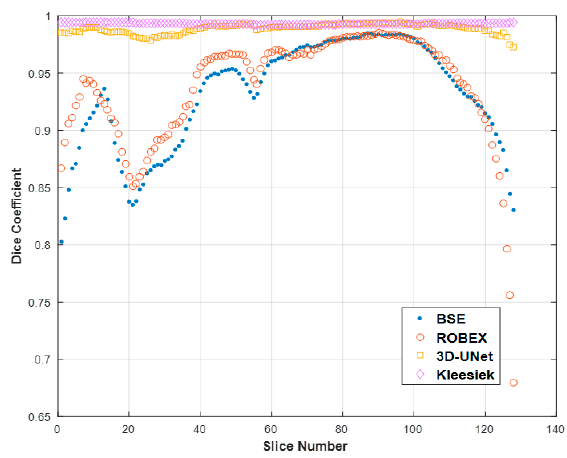
Figure 3. Dice comparison of 3D-UNet with BSE, ROBEX and Kleesiek’s method on a single test brain MRI scan slice-by-slice. BSE and ROBEX failed to correctly segment the brain in the initial slices of the brain MRI volume. The Dice score in the slices (from 80–140 slices) for both the competitor algorithms is less than 0.90 (on average).